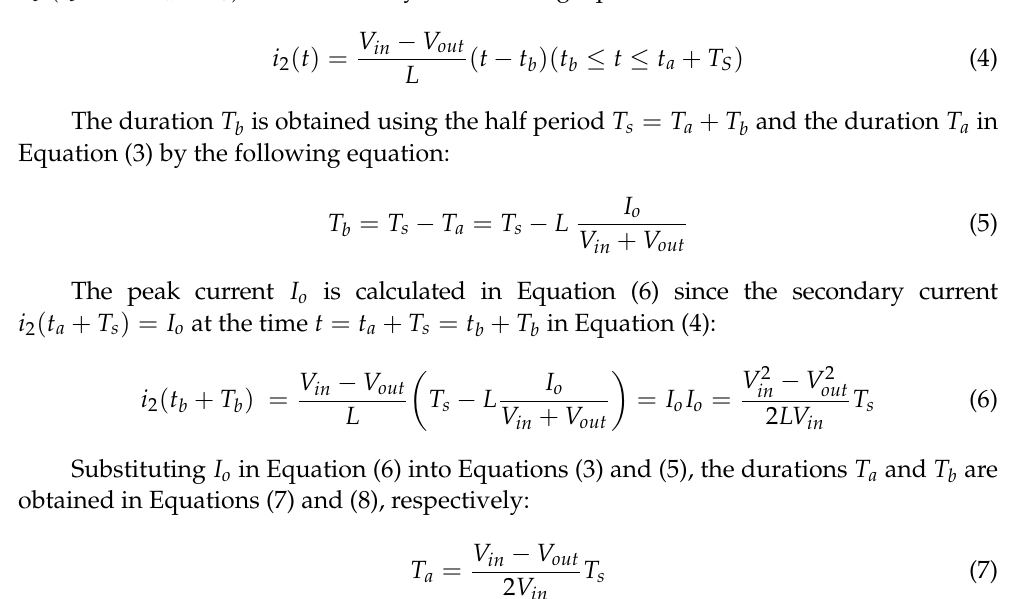
= V in and the turn-on of 1 = V in and the secondary volt- 1